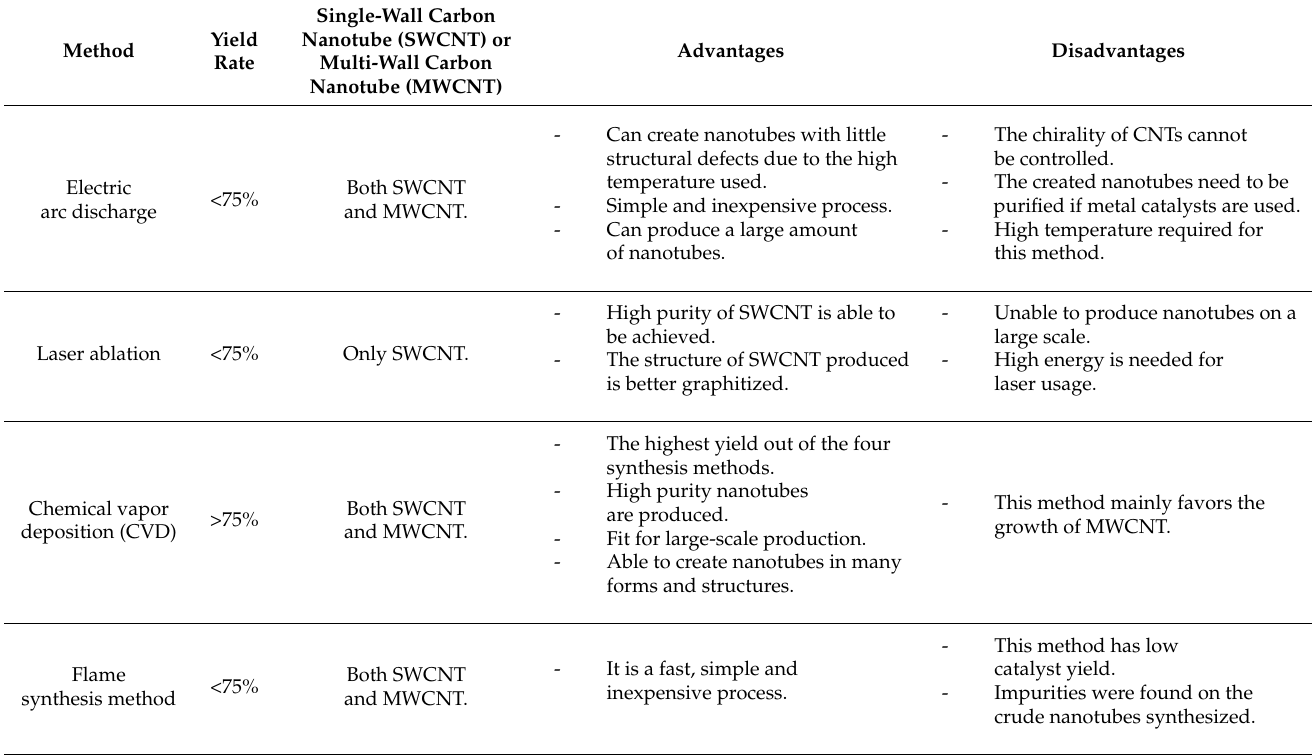
Table 4. Summary and comparison between CNT synthesis